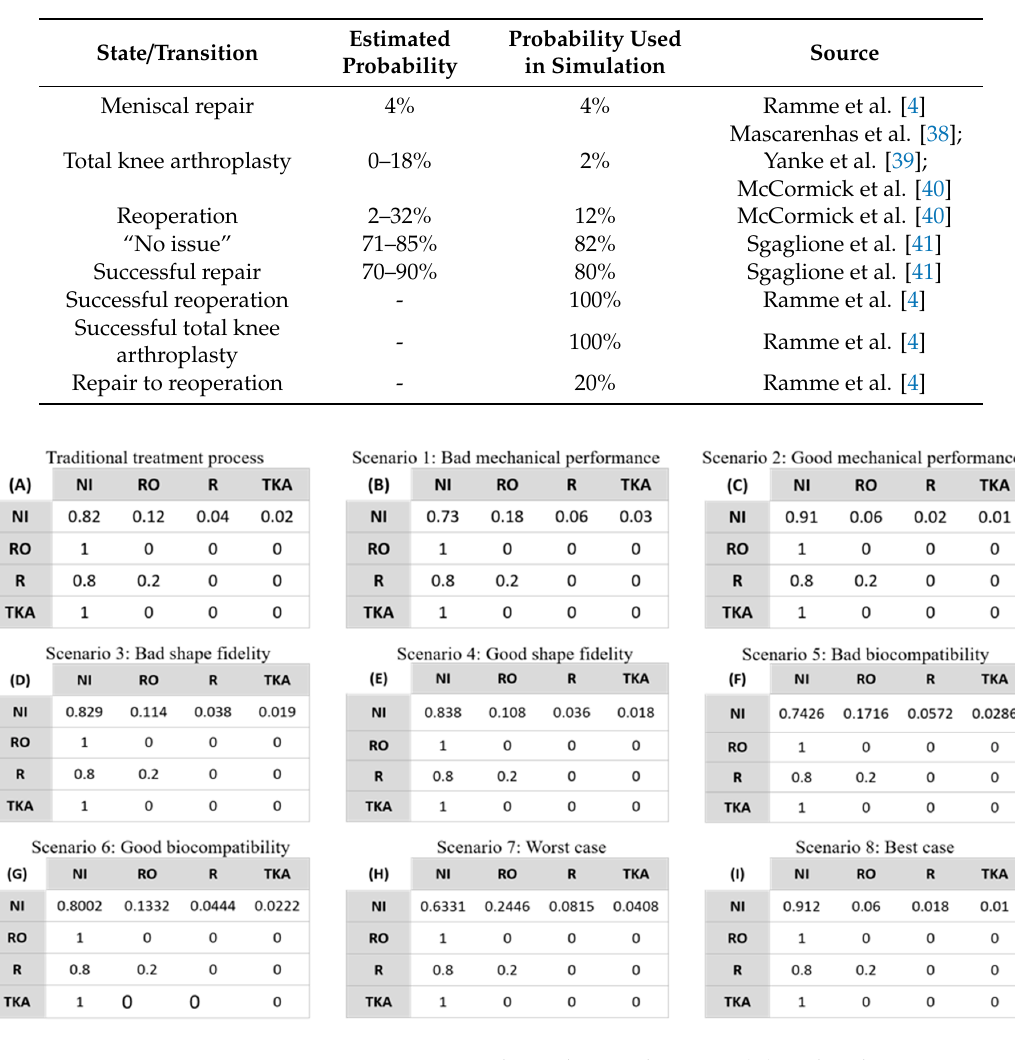
Figure 3. Post-treatment transition matrix: traditional transplantation ( A ) and eight scenarios in 3DP-enabled transplantation ( B–I ). 3DP-enabled transplantation ( B–I